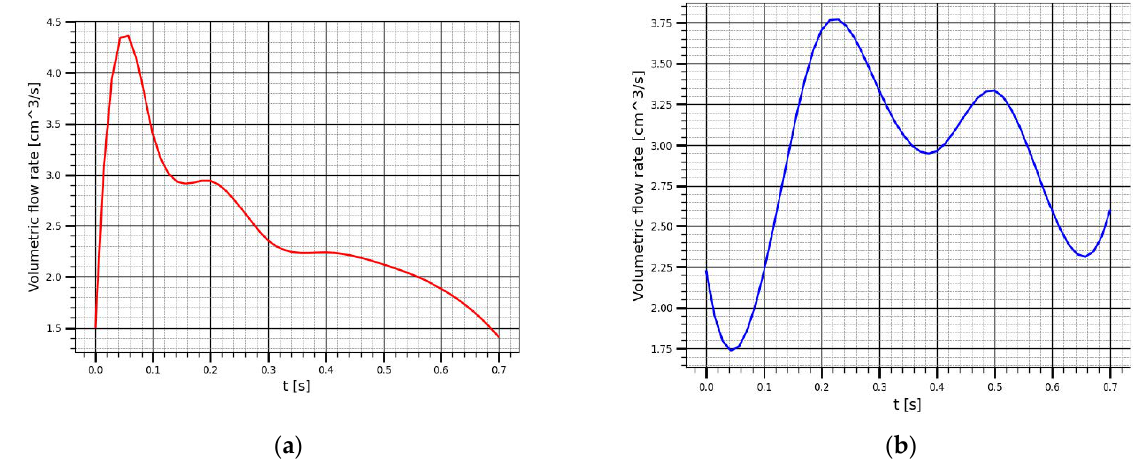
Figure 10. This volumetric flow rate in: ( a ) The renal artery; ( b ) The renal vein. Figure 11 show the result of the bio-impedance pulse behavior comparing with the blood volume change within the kidney obtained using ultrasound.